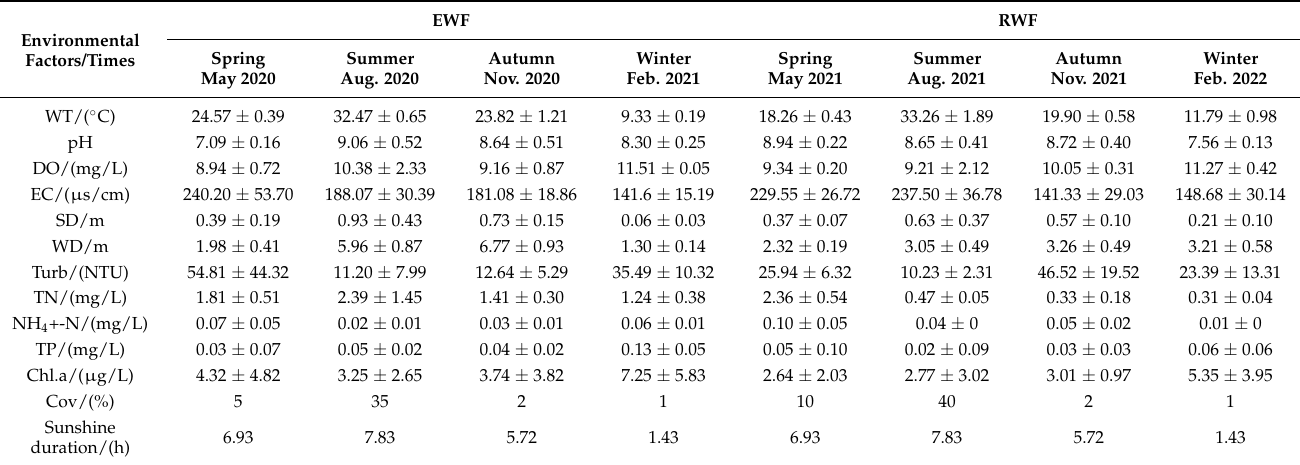
Table 1. Environmental parameters during the survey period.